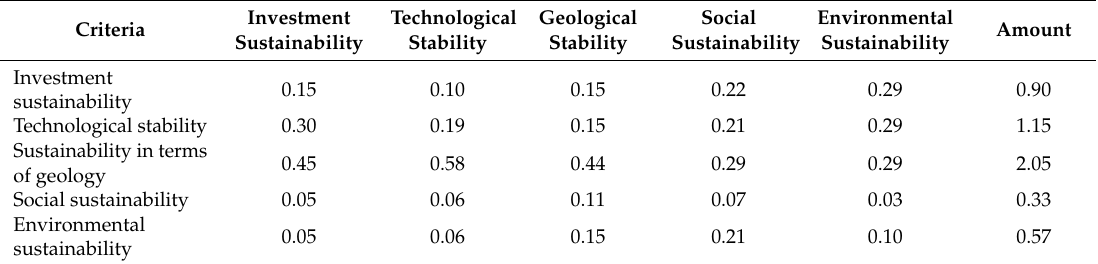
Table A1. Results of normalized assessment of the relative importance of Level 1 criteria.